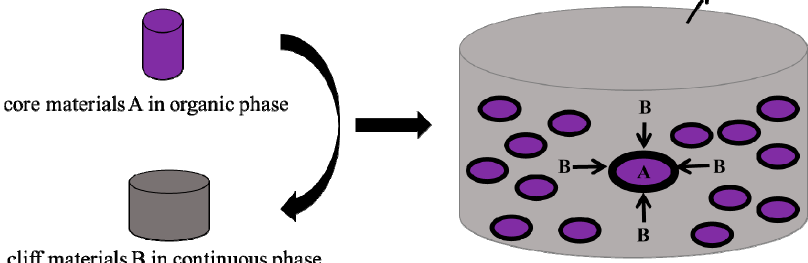
Figure 2. Microencapsulation with interfacial polymerizatio n.